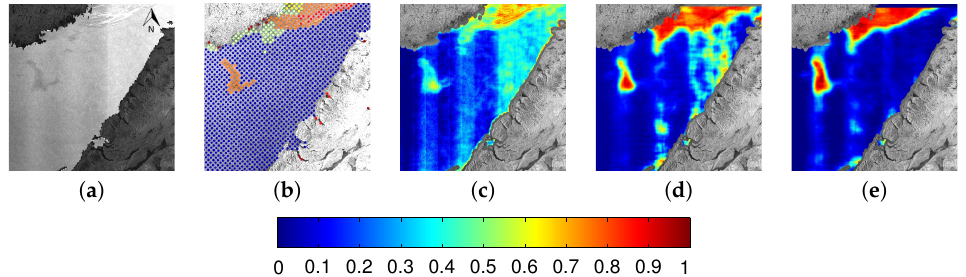
Figure 7. Example of water misidentified as ice for both MLP40 and CNN due to the banding effect in HV pol. Water in the right part of HV pol ( a ) is obviously brighter than water in the left. Water regions are estimated incorrectly for MLP40 ( c ), and CNN with patch size 45 ( d ). Results from the CNN are improved when a patch size of 55 is used, as shown in panel ( e ), although the features are also less sharp. Subscene centered at 49.72 ◦ N, 59.11 ◦ W of dimension 200 km × 200 km from 20140121_214420. Image analysis is shown in panel ( b